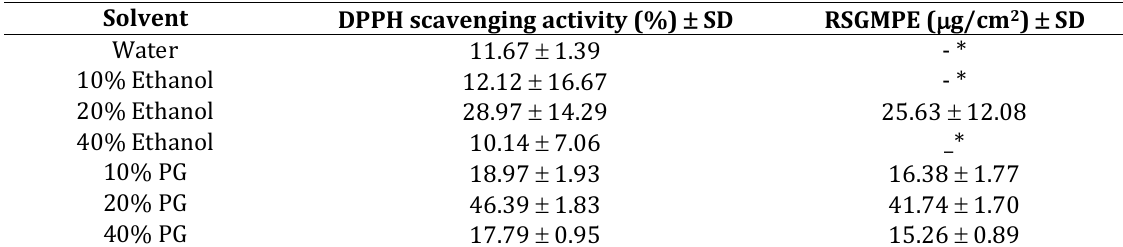
Table I. Percentage of radical DPPH scavenging activity and corresponding RSGMPE concentration estimated to the permeation